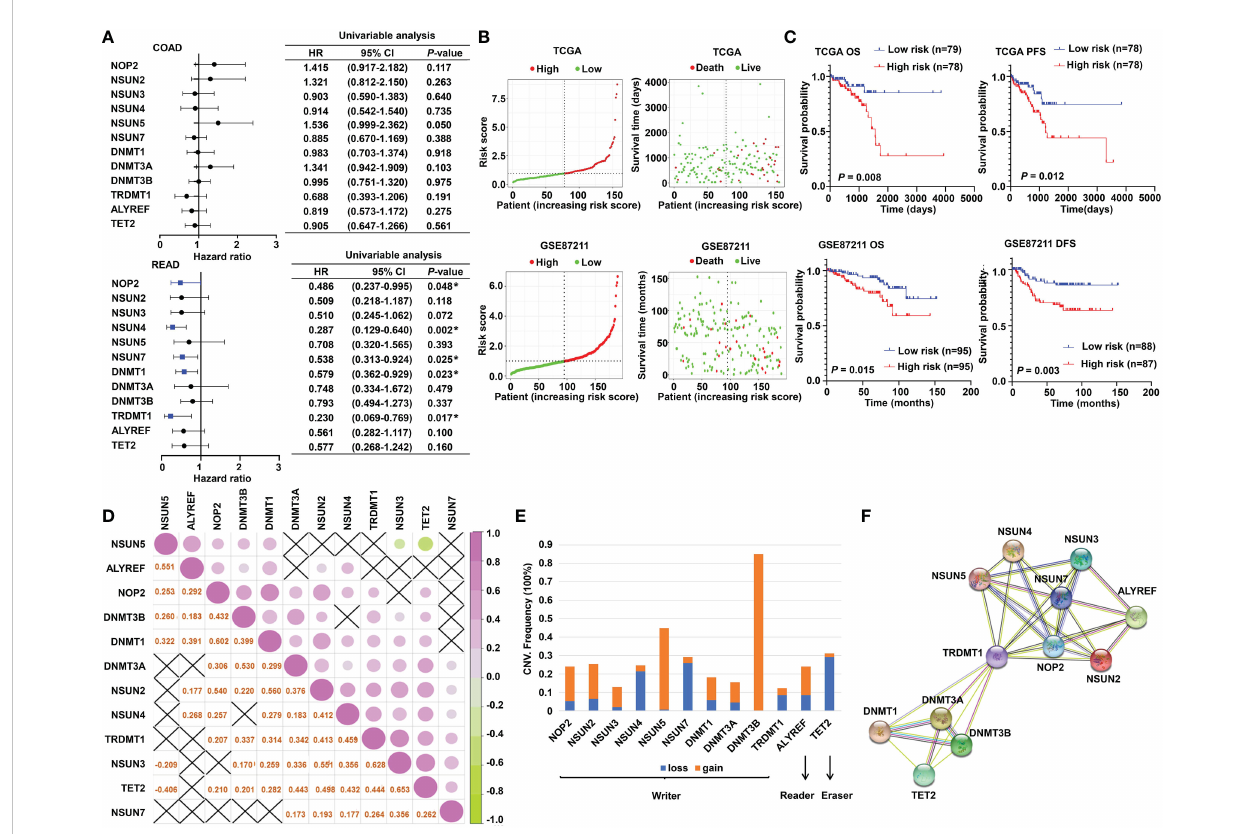
FIGURE 2 The prognostic value of m 5 C RNA methylation regulators. (A) Forest plot of the prognostic ability of the m 5 C regulator genes in COAD and READ separately. (B) The risk score distribution and patient survival status are shown in ranked dot and scattered plots based on the expression of m 5 C regulator genes. (C) The Kaplan – Meier curves for OS, PFS, and DFS between the high-risk and the low-risk groups in READ from the TCGA and GSE87211 cohorts. (D) Pearson correlation among the m 5 C regulators in READ patients. (E) The CNV variation frequency of the m 5 C regulators in the TCGA cohort. The orange rectangle = the ampli fi cation frequency; the blue rectangle = the deletion frequency. (F) The PPI network depicted for m 5 C regulators. CI, con fi dence interval; DFS, disease-free survival; HR, hazard ratio; OS, overall survival; PFS, progression-free survival. * P <